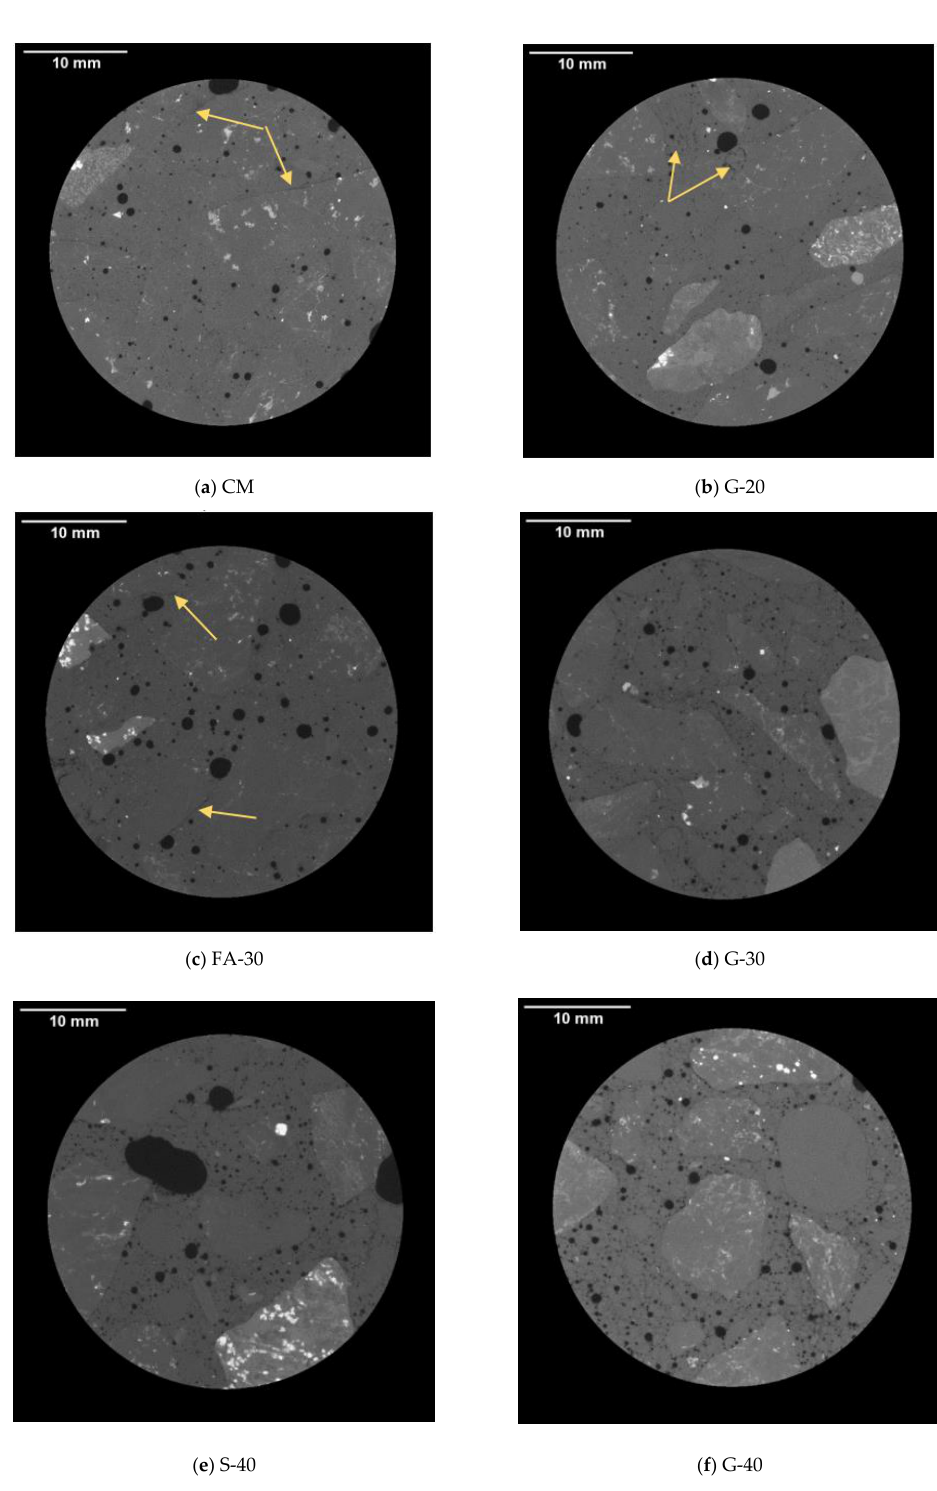
Figure 12. Micrographs for micro-cracking analysis at 1000 freeze–thaw (FT) cycles.